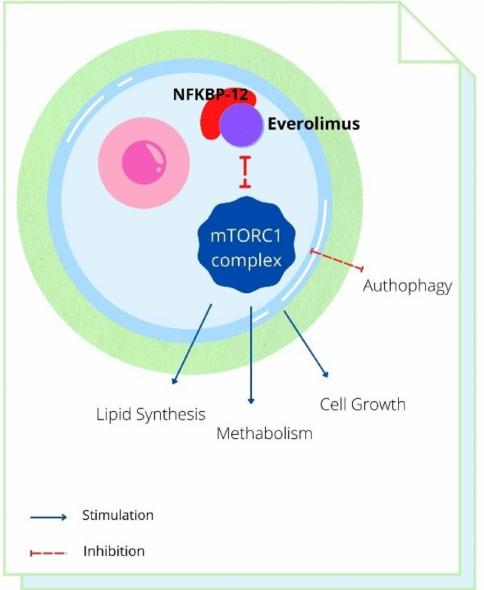
Figure 1. mTORC1 complex is involved in lipid synthesis and metabolism: Everolimus plus NFKBP- 12 has a negative